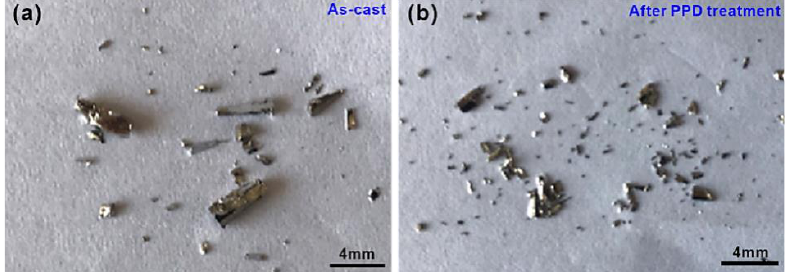
Figure 5. Fracture morphologies of the Fe 48 Cr 15 Mo 14 Y 2 C 15 B 6 BMG ( a ) in the as-cast state and ( b ) after PPD treatments.